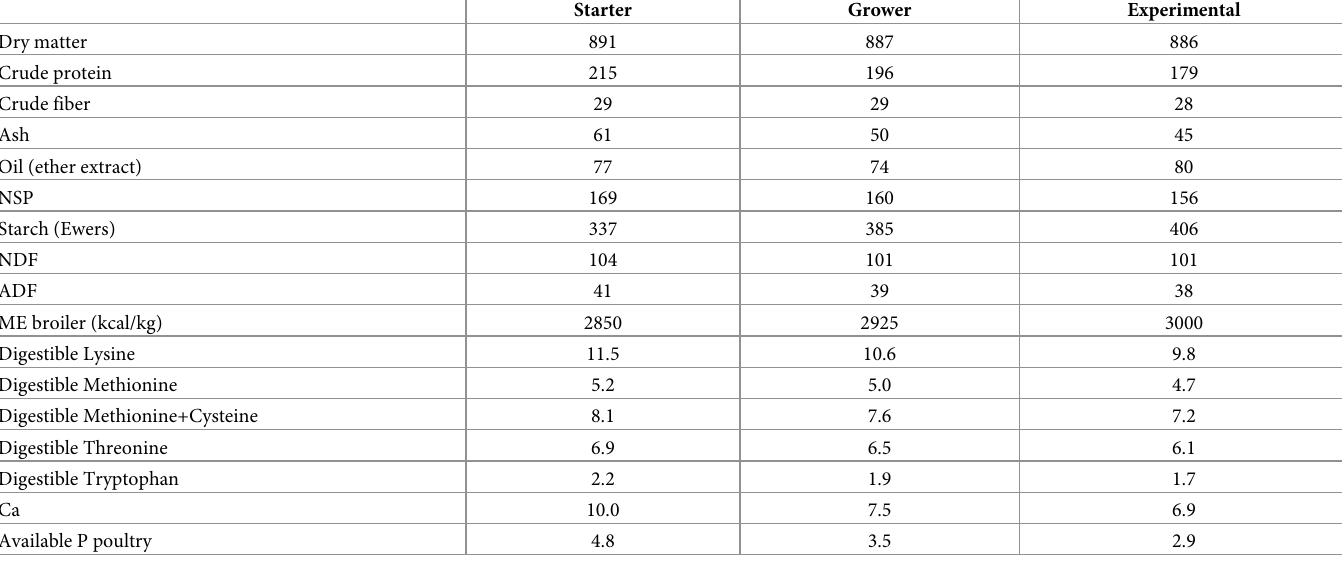
Birds were assigned to treatment using a randomized complete block design (with location in the facility as the blocking factor) to either T or T-Ac supplied at 5 different levels with either 16 individual birds or 2 pens with 32 birds each for each dose x treatment combination. As an Table 2. Nutrient composition (g/kg, except where noted) of the adaptation and experimental diets. Starter Grower